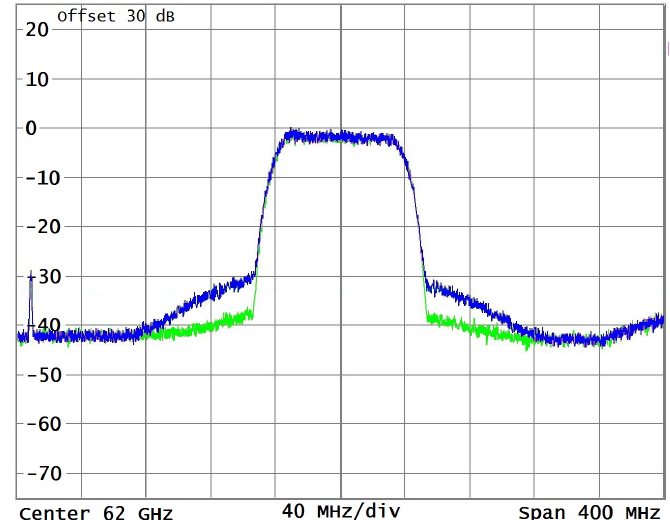
Figure 9. Example of the measured spectrum of a 16 QAM signal at a QPW power amplifier output with (green) and without (blue)